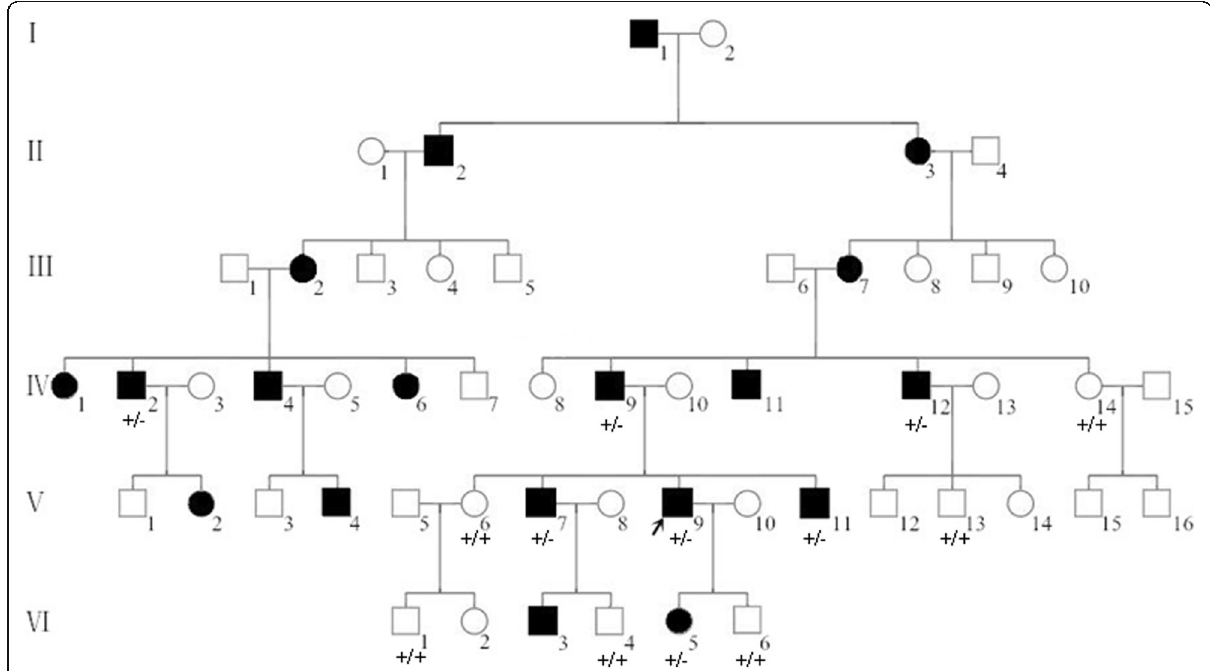
Fig. 1 Pedigree and genotypes of the late-onset deafness family. V-9 is the proband. +/ − : heterozygous for OSBPL2 , +/+: wild type for OSBPL2 . Members with genotypes noted were recruited for this